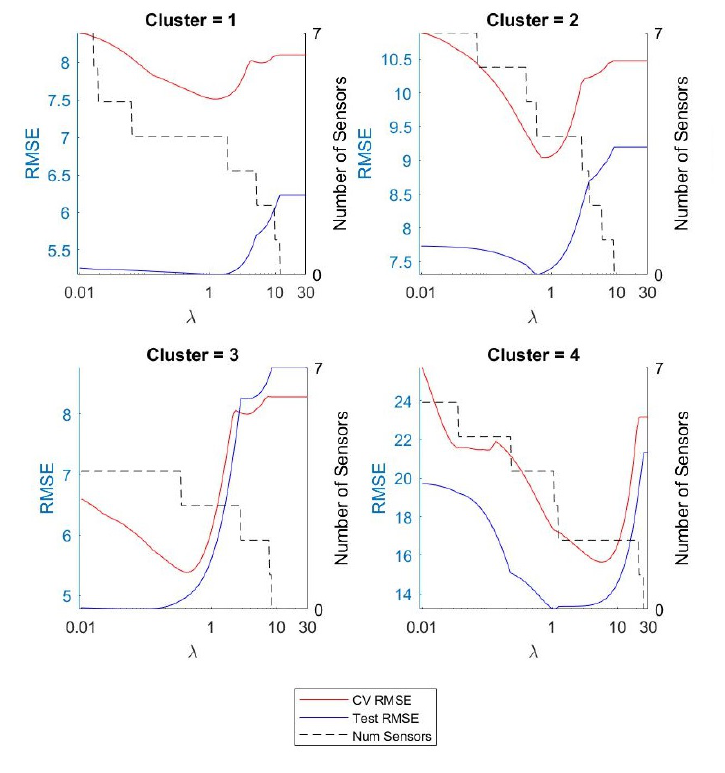
Figure 4. RMSE and number of sensors used versus λ for each cluster.